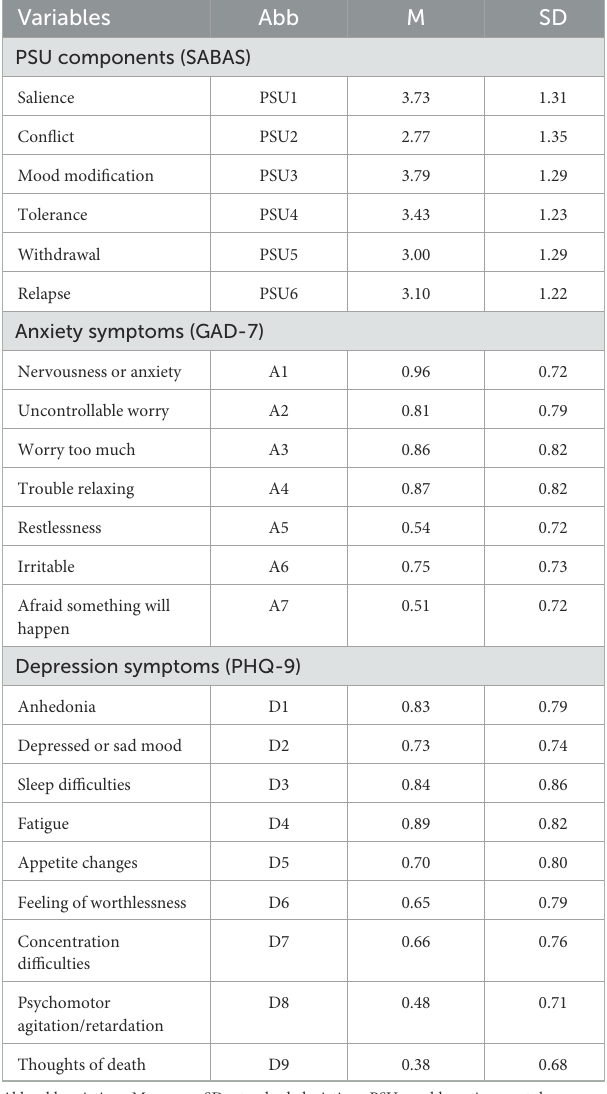
TABLE 1 Abbreviations, mean scores, and standard deviations for the study variables.